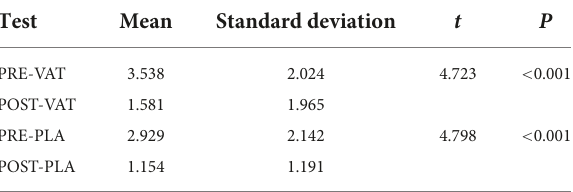
FIGURE3 Ratio of low frequency to high frequency power (LF/HF) parameter for lying position (VAT, vibroacoustic therapy, experimental group; PLA, placebo, control group; PRE, pre-test; POST, post-test). TABLE 4 Pre-test post-test difference for VAS-S in experimental (VAT)